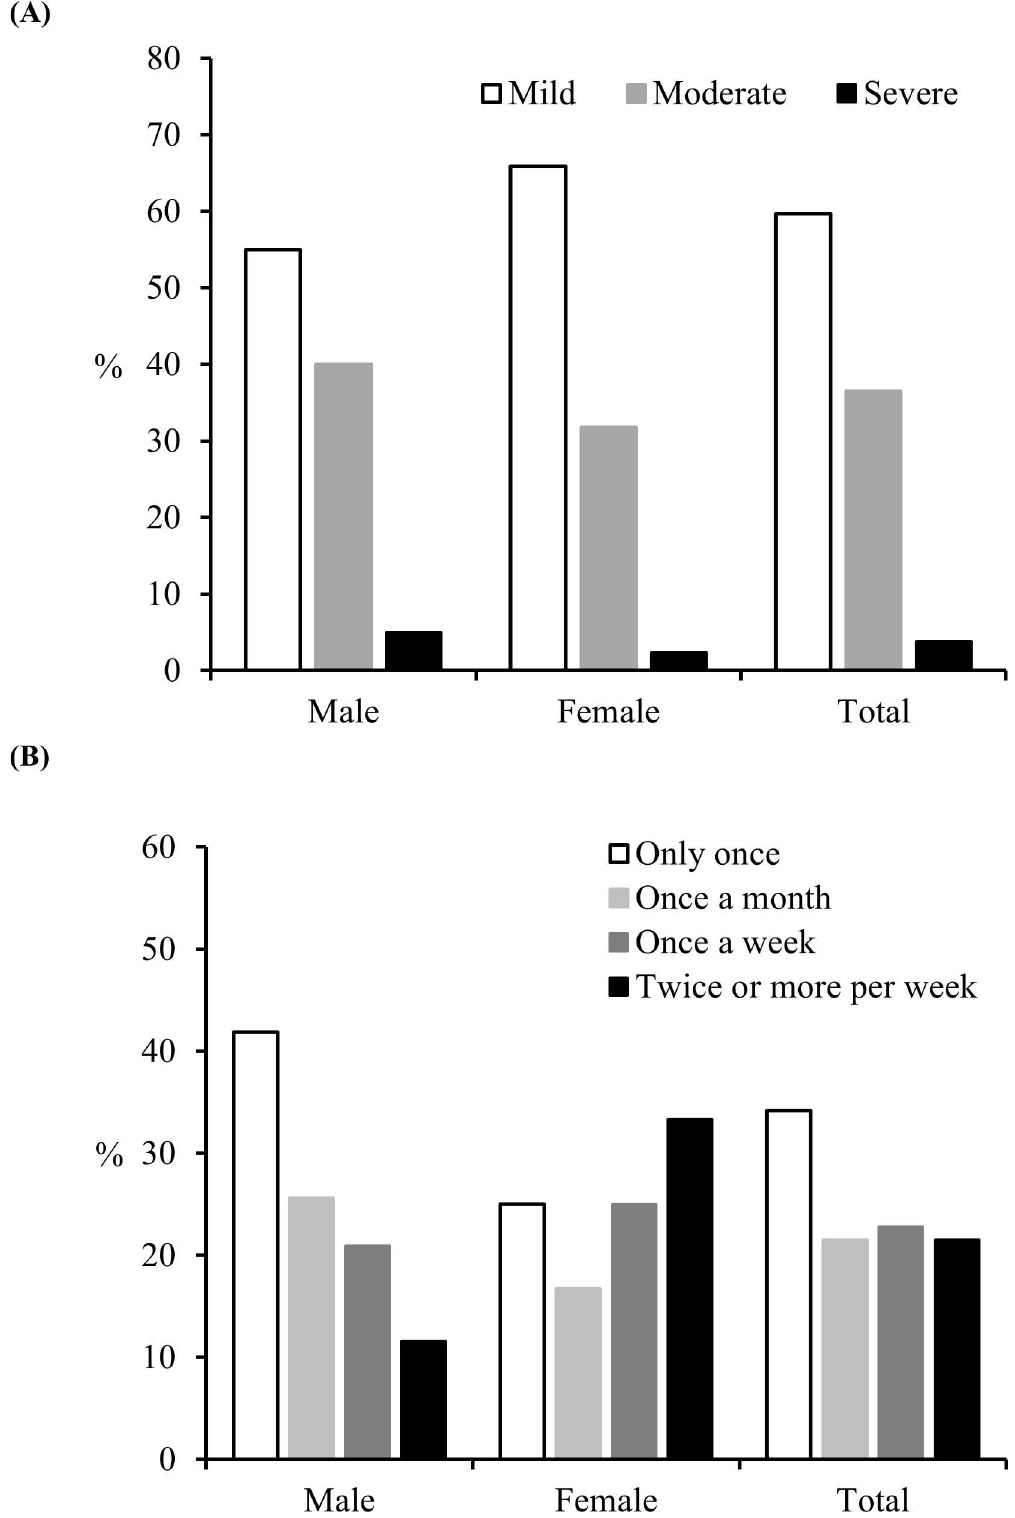
Fig 1. Prevalenceof back pain intensity (A) and back pain frequency(B) in the previous 3 months.